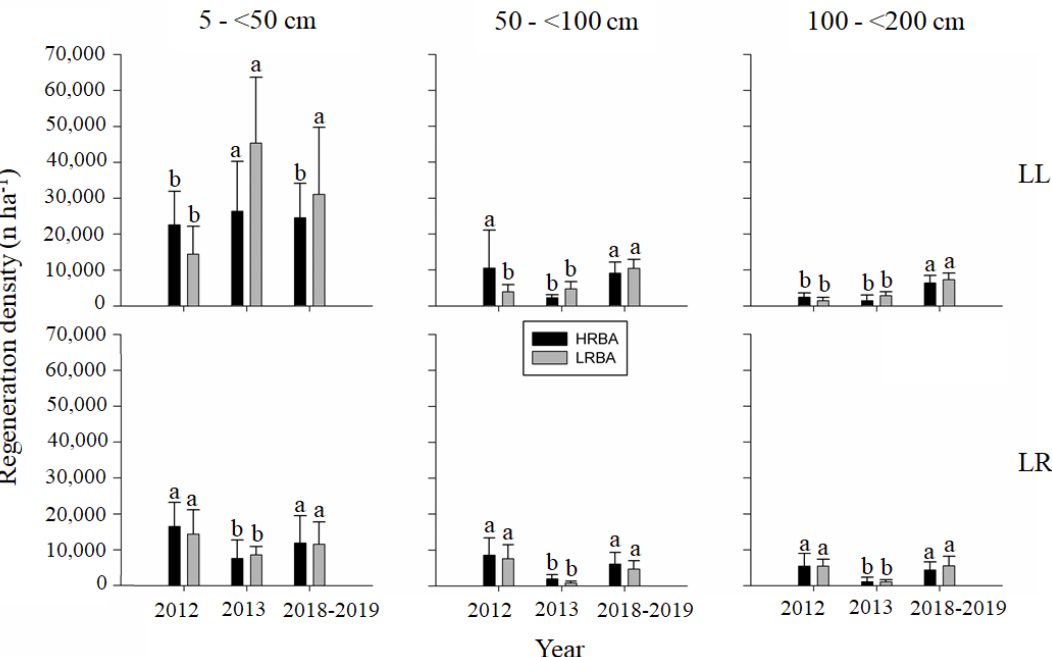
Figure 7. Mean (bars) and standard deviation (whiskers) in the density of seedlings (n ha − 1 ) for shade-tolerant species according to height classes (5– < 50 cm; 50– < 100 cm; 100–200 cm), year, treatment and site. Di ff erent letters between bars of the same color show significant di ff erences between measurement years ( p -value < 0.05).